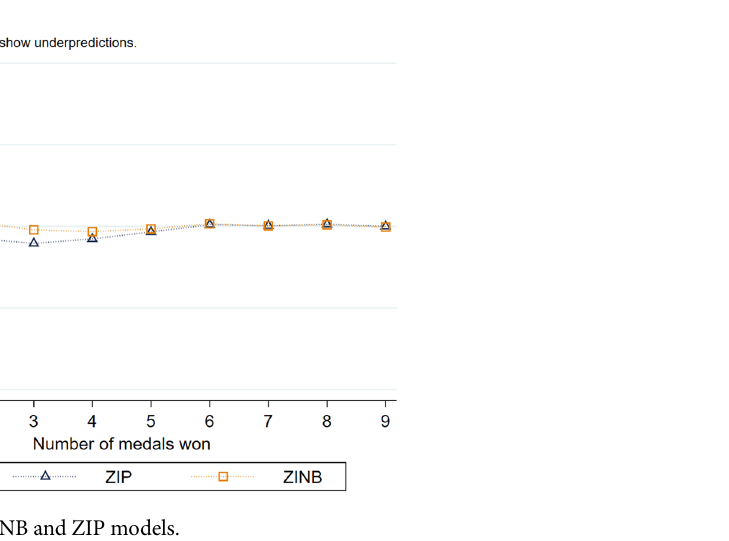
Figure 3. Fitting of ZINB and ZIP